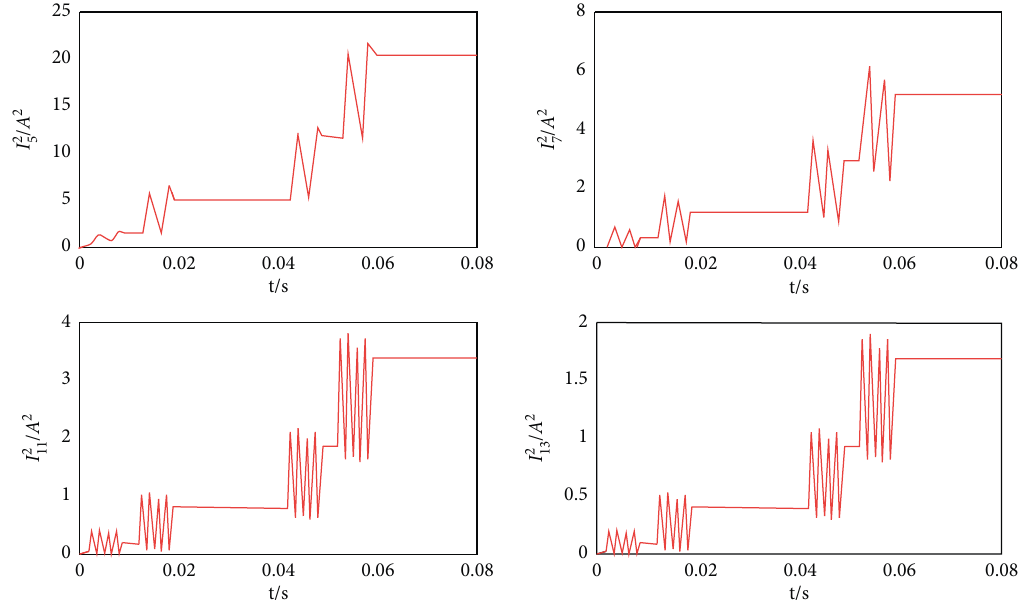
Figure 7: The result of extracting the RMS value of the 5th, 7th, 11th, and 13th harmonic currents based on the RDFT